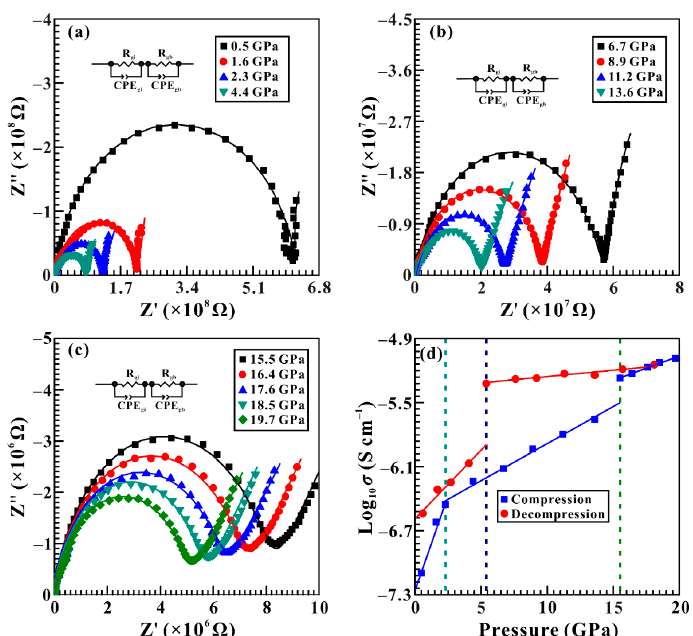
Figure 6. Complex impedance spectra of calcite at the atmospheric temperature within the pressure range of 0.5 ‒ 19.7 GPa. ( a ) 0.5 ‒ 4.4 GPa; ( b ) 6.7–13.6 GPa; ( c ) 15.5–19.7 GPa. ( d ) The pressure depend- ence of the logarithmic electrical conductivity of calcite in both processes of compression and de- compression. Here, the symbols of Z’ and Z” represent the real and imaginary parts of complex impedance spectra. The colored curves are the results of the fitting to the impedance spectra. The colored dashed lines and solid lines are employed to guide the eyes. The electrical conductivity of calcite ( σ ) is calculated on the basis of the following equation: σ = L / SR (1) where L is the experimental sample length (cm), S is the cross-sectional area of electrode (cm 2 ), and R is the resistance of sample ( Ω ), respectively. Figure 6d exhibits the pressure- dependent logarithmic electrical conductivity of calcite in both compressed and decom- pressed processes at room temperature. In light of the pressure-dependent electrical con- ductivity relation, three separate pressure regions were distinguished upon compression: (i) from 0.5 GPa to 2.3 GPa, the logarithmic electrical conductivity rapidly increased with a steep slope of 0.36 S cm − 1 GPa − 1 ; (ii) from 2.3 GPa to 15.5 GPa, a gentle slope of 0.07 S cm − 1 GPa − 1 was acquired; (iii) from 15.5 GPa to 19.7 GPa, the logarithmic electrical conduc- tivity values kept stable with a tiny slope of 0.03 S cm − 1 GPa − 1 . According to the high-